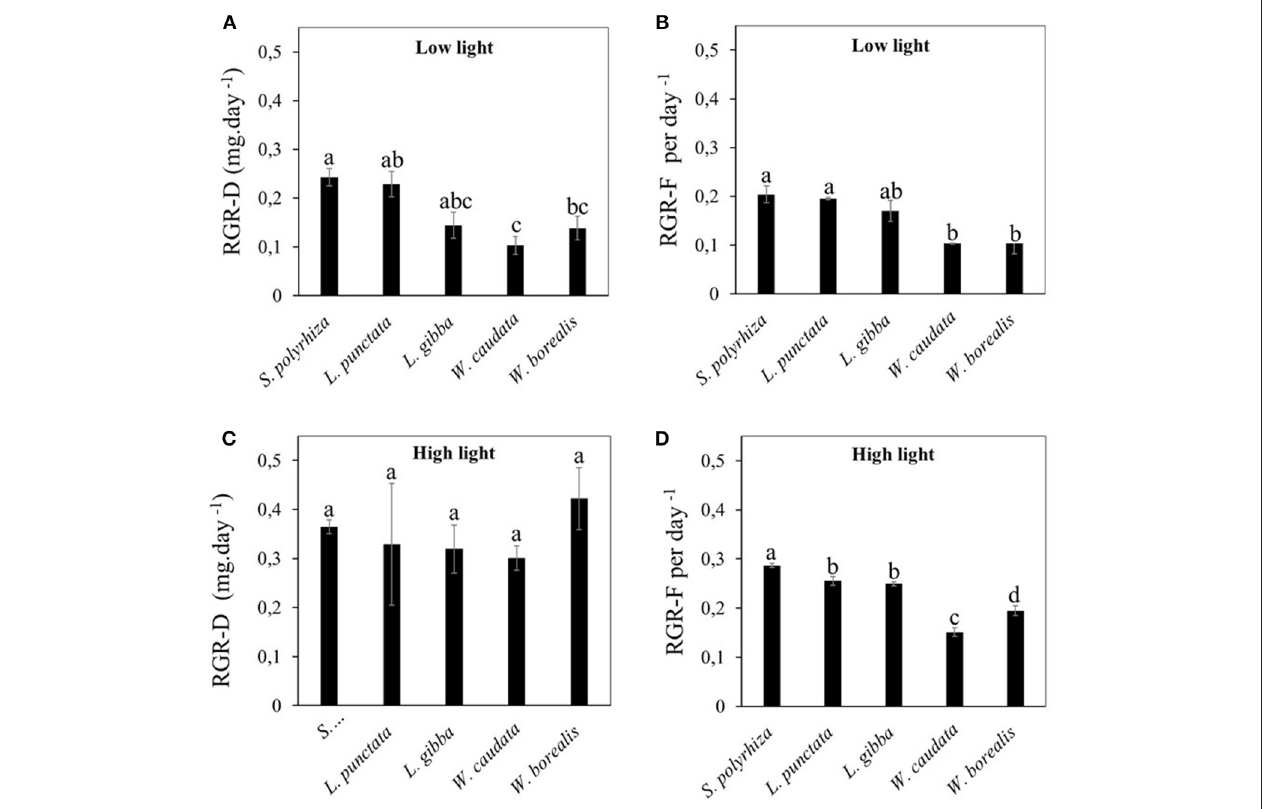
FIGURE 2 | Comparison of relative growth rate (RGR) for different duckweed strains ( S. polyrhiza, L. punctata, L. gibba, W. caudata , and W. borealis ) cultivated under two light intensities (20 µ mol.m − 2 .s − 1 and 500 µ mol.m − 2 .s − 1 ). Values are average ± standard error evaluated per dry mass (A,C) and the number of fronds (B,D) . (A,B) show data from low light condition while (C,D) represent data from high light condition. Means followed by the same letters are statistically significant among the five species compared according to Tukey’s test ( p < 0.05).